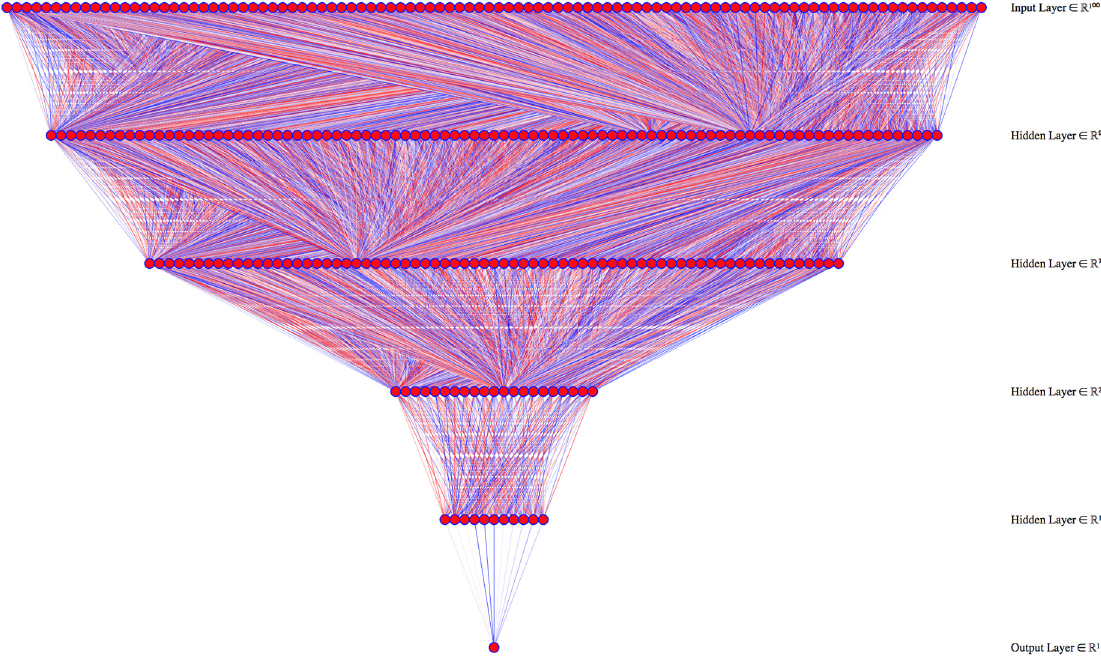
Figure 6. Deep learning model architecture for the percentage of separate collection, using 100 learning epochs to train the